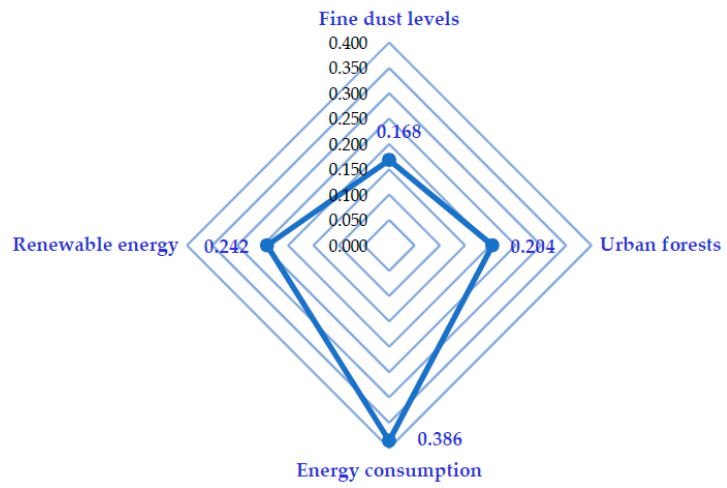
Figure 13. Relative weights of the assessment indicators for “Air Quality and Energy”.